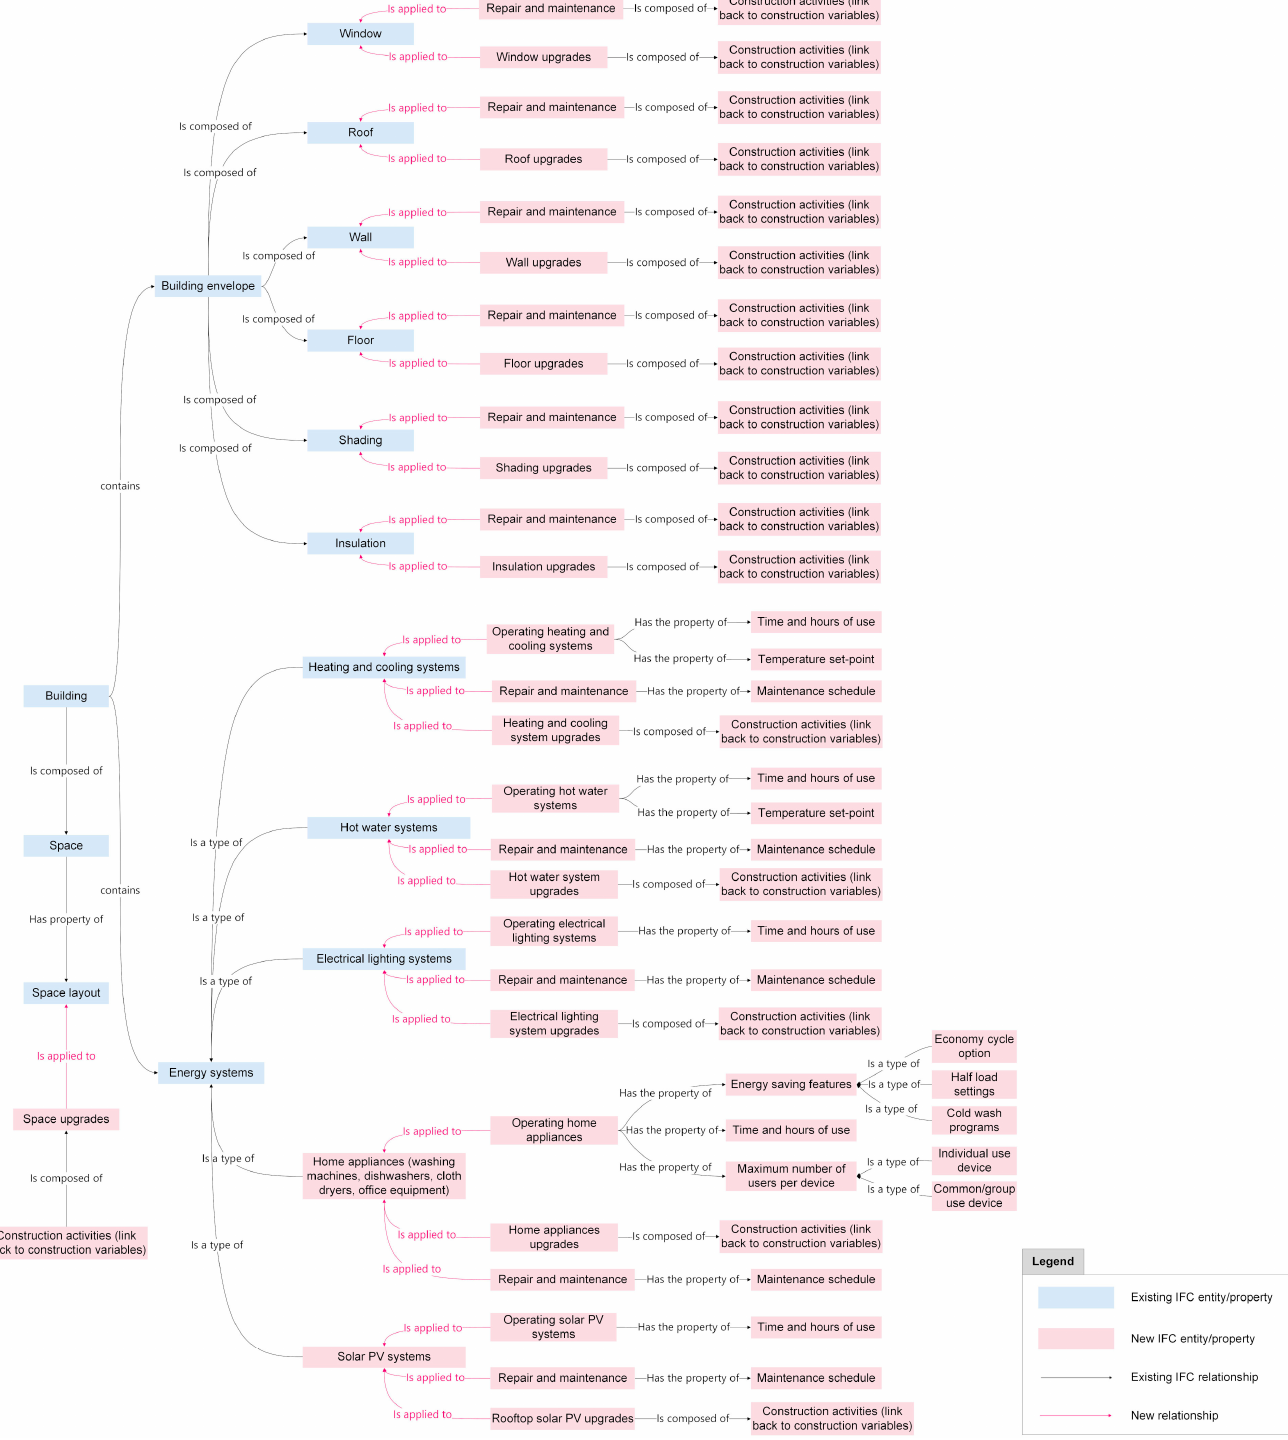
Figure 15. Illustration of an extension of additional IFC entities, properties, and relationships to represent key decision variables affecting net-zero-carbon building outcomes at operational stage, and the links to the existing IFC